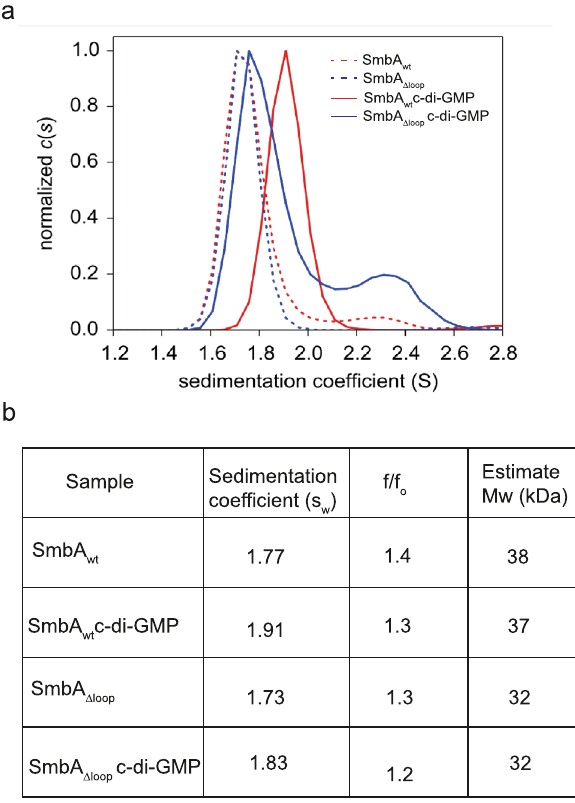
Figure 4. Analytical ultracentrifugation (AUC) analysis of SmbA wt and SmbA Δloop . ( a ) SV-AUC absorbance c(s) distributions of SmbA wt , SmbA wt /(c-di-GMP) 2 , SmbA Δloop and SmbA Δloop /c-di-GMP. ( b ) Mass estimation and s and f/f O values of SmbA wt , SmbA wt /(c-di-GMP) 2 , SmbA Δloop and SmbA Δloop